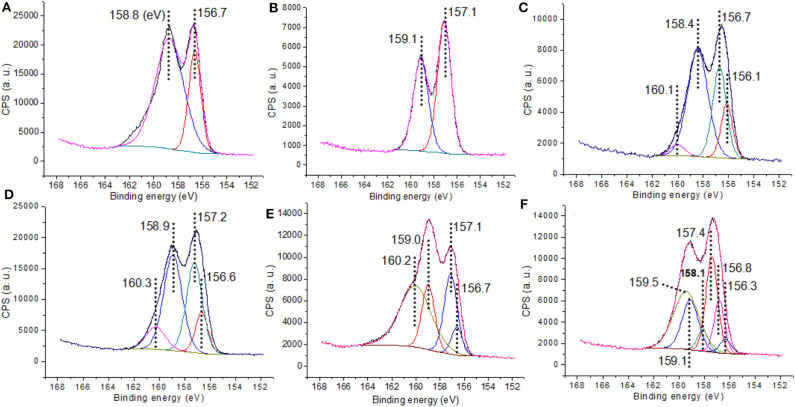
XPS spectra of Y 3d region for (A) C1, (B) C2, (C) C3, (D) C4, (E) C1g, and (F) C4g.